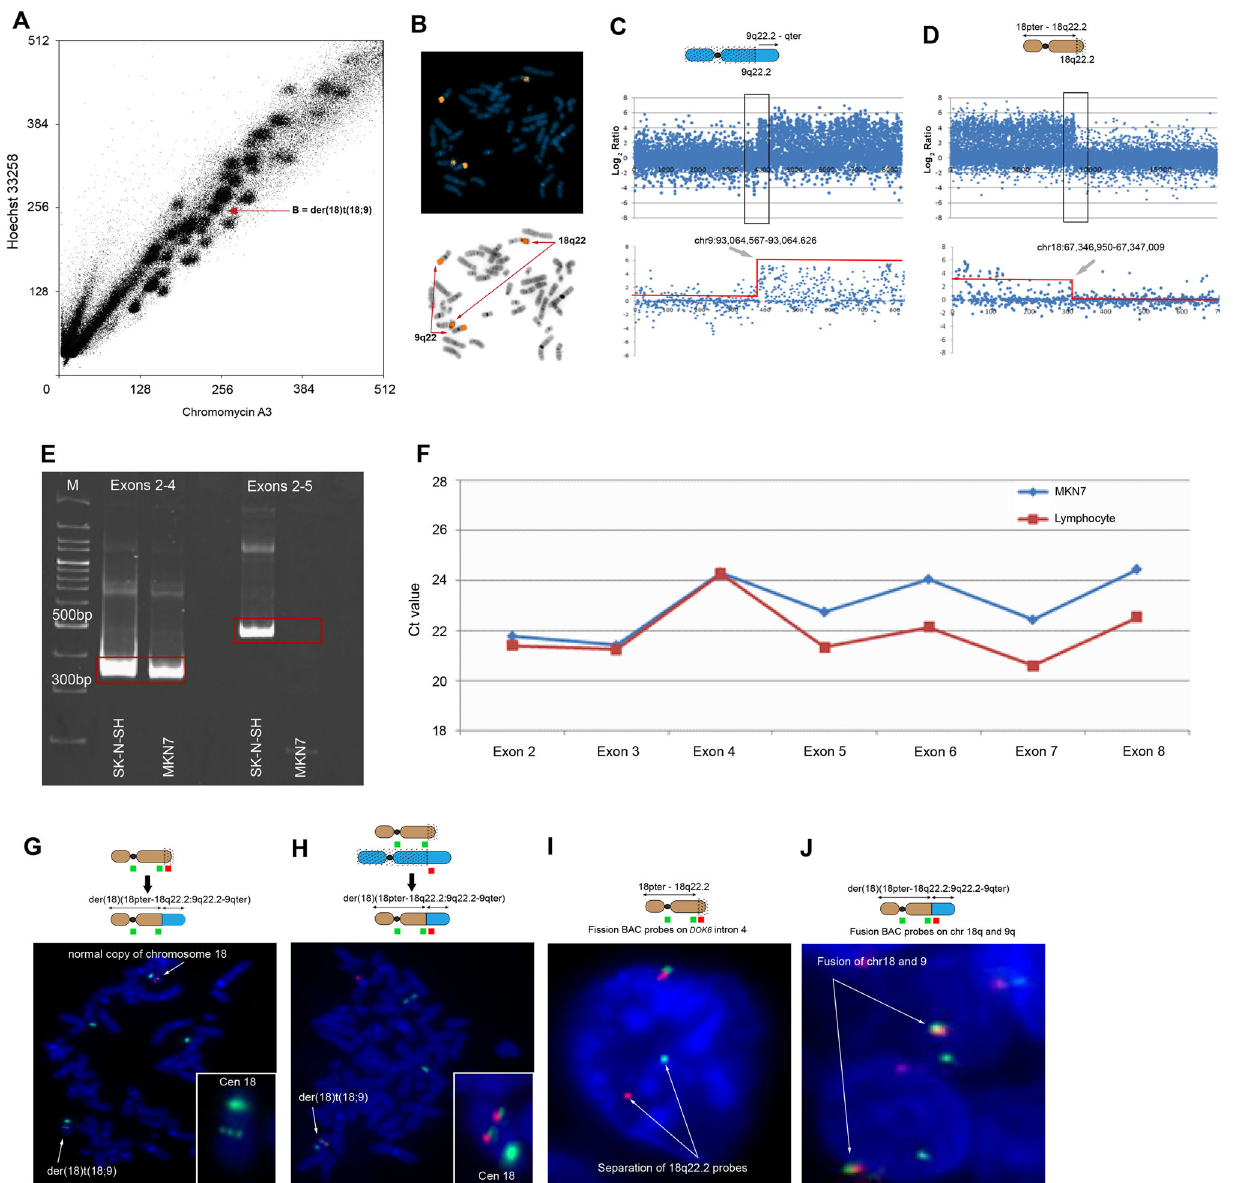
and MKN7 cDNA. Expression of DOK6 mRNA was determined in two exonic segments: exons 2 – 4 and exons 2 – 5. Both exonic segments of correct predicted sizes were expressed in SK-N-SH cells while MKN7 cells expressed only exons 2 – 4. f Exon-speci fi c real-time genomic PCR of individual DOK6 exons (2 – 8) of MKN7 cells and normal human lymphocytes. C t values diverge after exon 4 and are uniformly higher for MKN7. Primer sequences for ( e ) and ( f ) are in Supplementary Table S1. g Fission FISH assay of MKN7 shows loss of red probe (G248P800714D5; telomeric of 18q22 breakpoint) in der(18). Inset: retention of the green probe (G248P89647A7; centromeric of breakpoint) in der(18). Both probes hybridized to normal chromosome 18. h Fusion FISH assay of MKN7 shows co-hybridization of probes for 18q22 (G248P89647A7; green ) and 9q22 (G248P889245F1; red ). Both insets show a strong green signal for chromosome 18 centromere. i Fission FISH assay on primary gastric cancer showing separation of 18q22 probes. j Fusion FISH assay on primary gastric cancer showing co-hybridization of 18q22 and